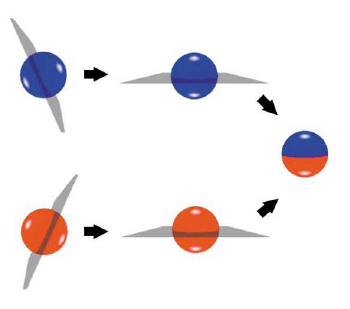
Figure 2. Illustration of phenotype cut and splice crossover operation developed by Deaven and Ho